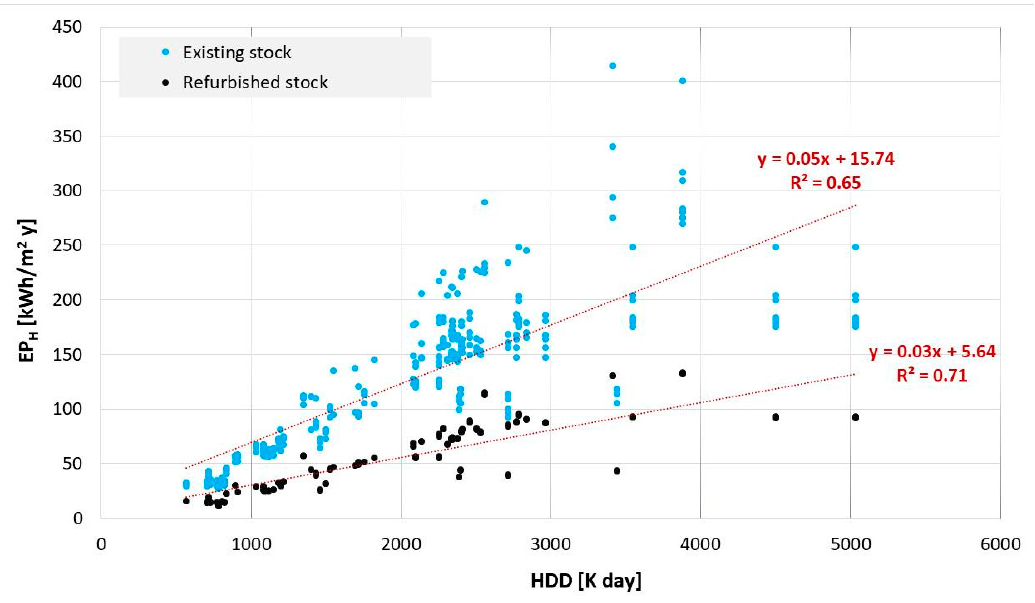
Figure 6. Primary energy for heating demand—all available weather files.